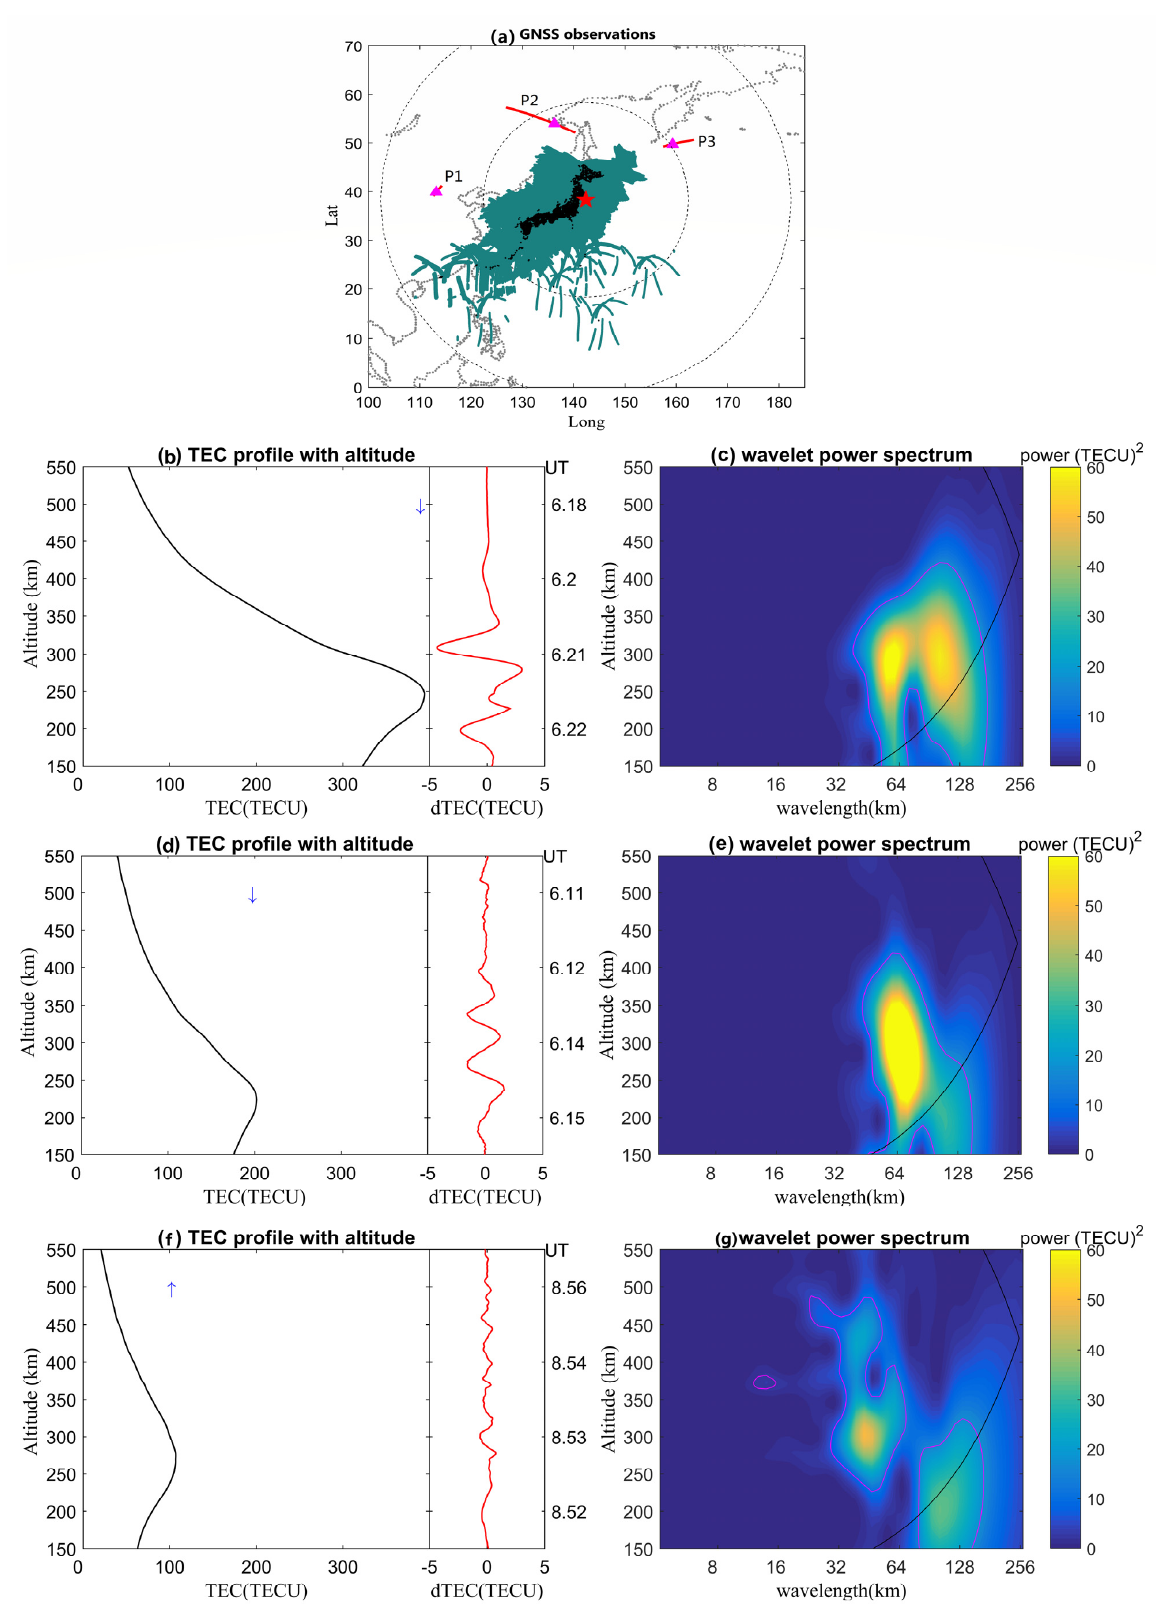
Figure 8. ( a ) Data used to track the wavefront after the 2011-03-11 earthquake/tsunami. Red curves represent the projections of the tangent points for F3/C profiles P1, P2, and P3, respectively. The